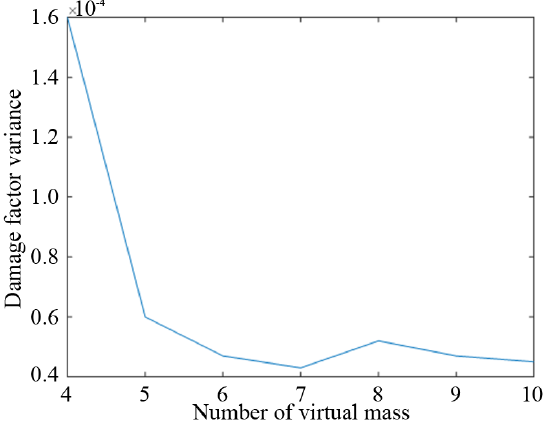
Figure 12. Variance of the damage factor when using different numbers of masses.